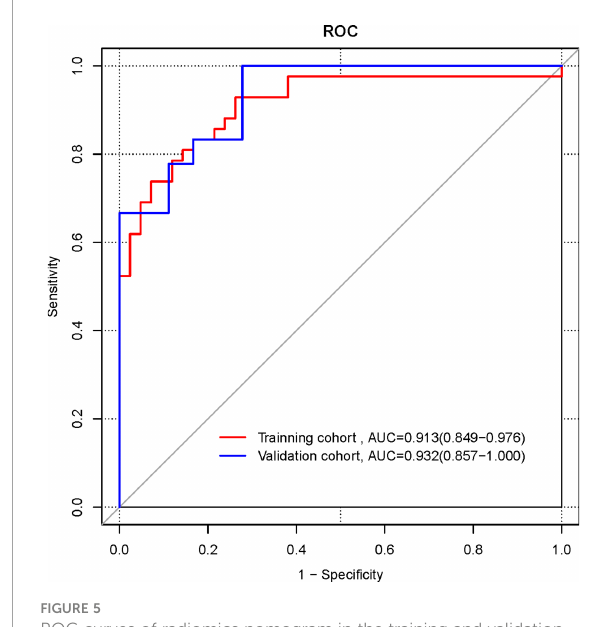
FIGURE 3 ROC curves of radiomics signature in the training and validation cohorts.